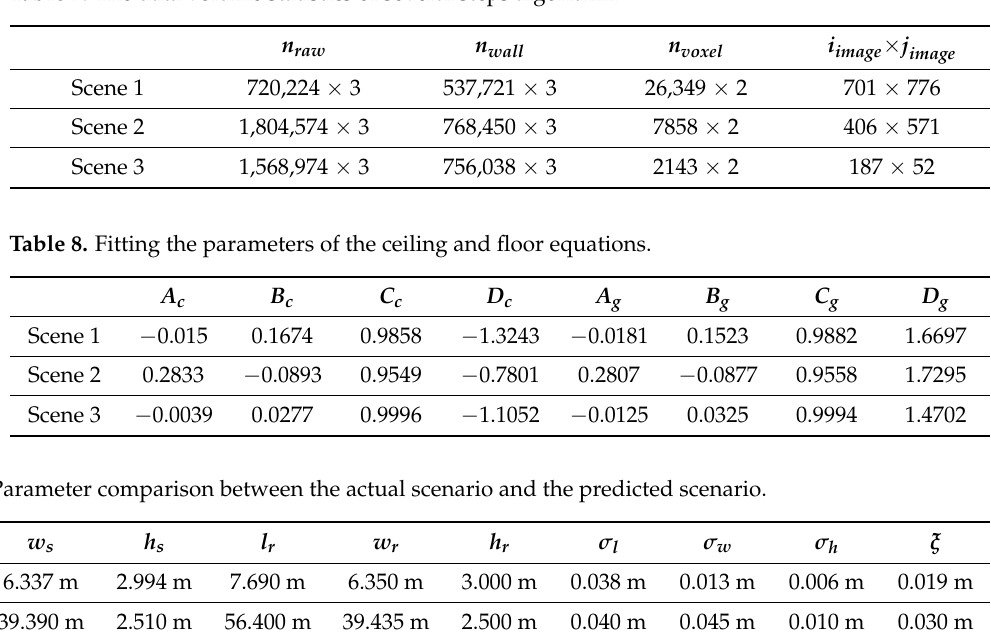
Table 7. The data volume statistics of several steps algorithm.